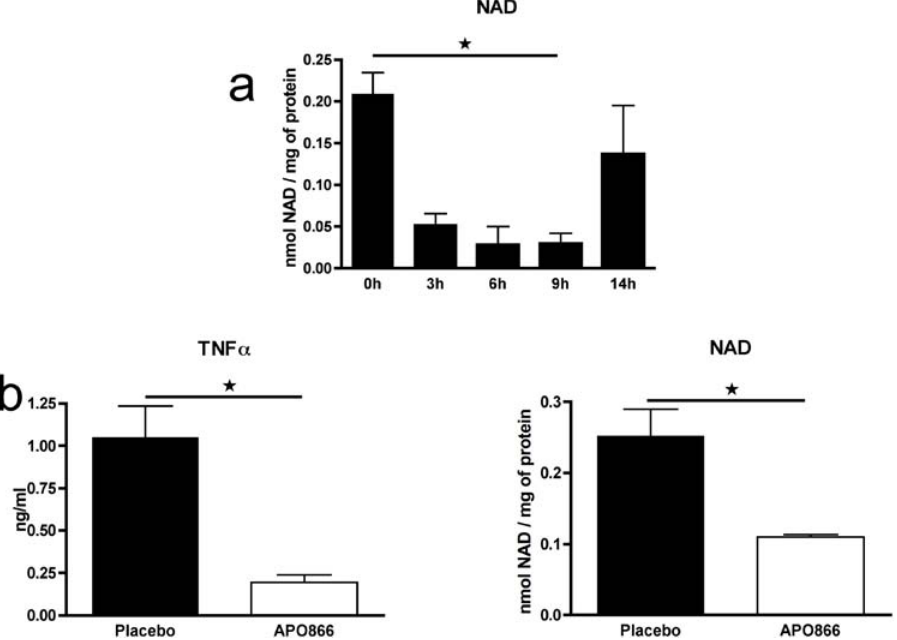
Figure 4. APO866 reduces intracellular NAD in PEC invivo and inhibits TNF a production after LPS challenge. ( a ) Mice were treated with thioglycollate to elicit PEC, and then received 10 mg/kg APO866 by ip injection. PEC were obtained by lavage after different time points and intracellular NAD was determined. Data are mean + sem of 3 mice per group. ( b ) Mice were treated with thioglycollate to elicit PEC, and then received 10 mg/kg APO866 or placebo by ip injection 7 h before ip challenge with LPS. Serum TNF a at 90 min (mean + sem of 3 mice per group is shown. PEC were obtained by lavage and intracellular NAD was determined. Data are mean + sem of 3 mice per group. This panel is representative of at least 4 experiments performed. P , 0.05 9 h versus 0 h in panel a, or APO866 versus placebo in panel